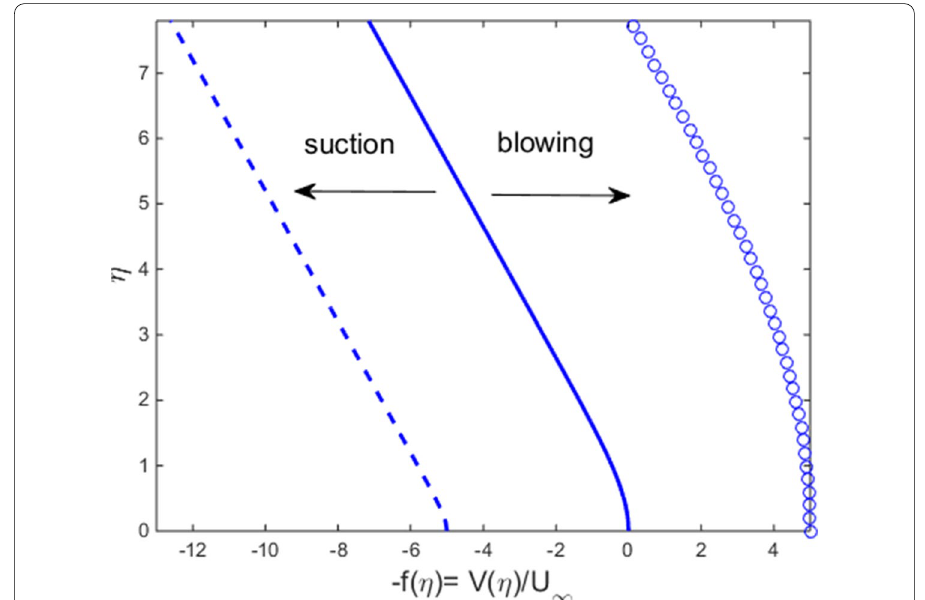
Fig. 3 Effect of normal mass flux blowing on the dimensionless wall normal velocity, from left to right: f w 0, ‐ 5, representing negative blowing-suction, standard case and blowing,